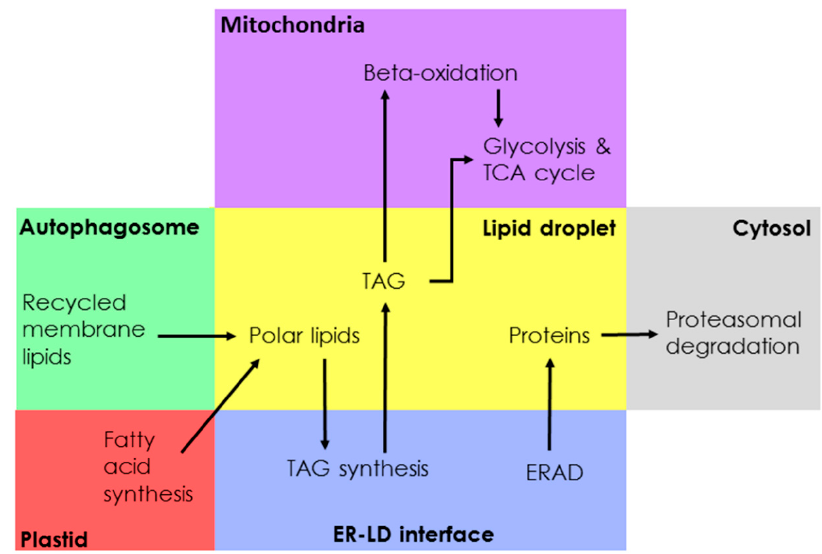
Figure 3. Simplified schematic of diatom LD metabolic network.